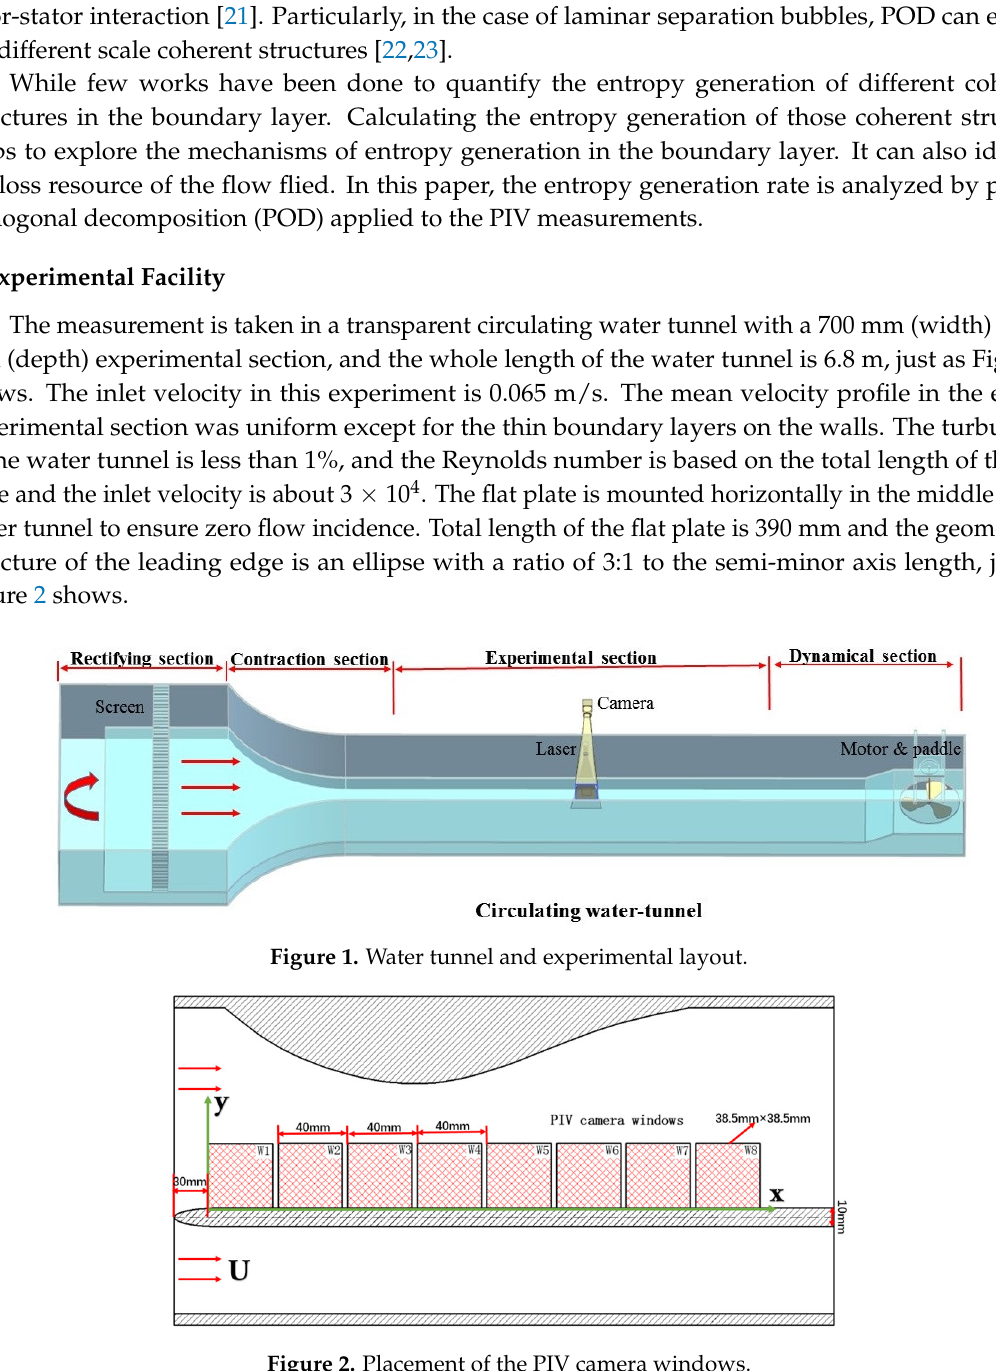
Figure 2. Placement of the PIV camera windows.